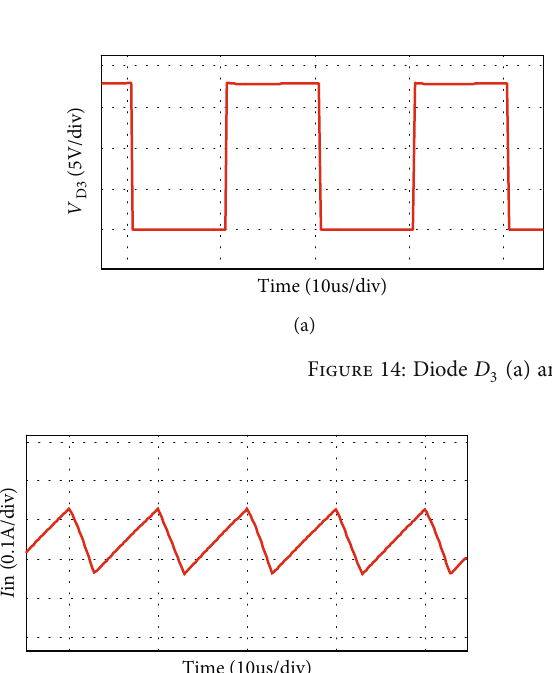
(a) and D (b) voltage waveform. 1 2